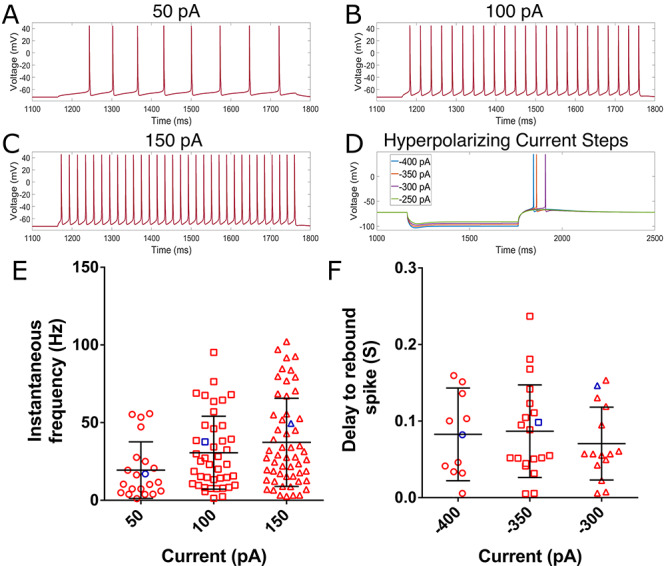
Model neuron exhibits reasonable repetitive and PIR spiking behavior. (A–C) Repetitive spiking behavior of the model neuron in response to 50 pA (A), 100 pA (B), and 150 pA (C) current steps. (D) PIR behavior in response to four hyperpolarizing current steps. (E) Butterfly plots of the instantaneous frequency (i.e. the frequency derived from the cell’s first two spikes) of a population of human L5 pyramidal cells characterized by Moradi Chameh et al. (2020), with black bars representing the mean \documentclass[12pt]{minimal}
\usepackage{amsmath}
\usepackage{wasysym}
\usepackage{amsfonts}
\usepackage{amssymb}
\usepackage{amsbsy}
\usepackage{upgreek}
\usepackage{mathrsfs}
\setlength{\oddsidemargin}{-69pt}
\begin{document}
}{}$\pm $\end{document} standard deviation. The blue marker represents the value for our model neuron. (F) Analogous plots to panel (E) from the same cells, but for the delay to the PIR spike following the release of the hyperpolarizing current step. Only cells that exhibit a PIR spike are shown here (as discussed in the Methods). In both panels (E) and (F) we see that the value derived from our model neuron (again, in blue) falls within the range exhibited by these neurons experimentally, often quite near the average value.